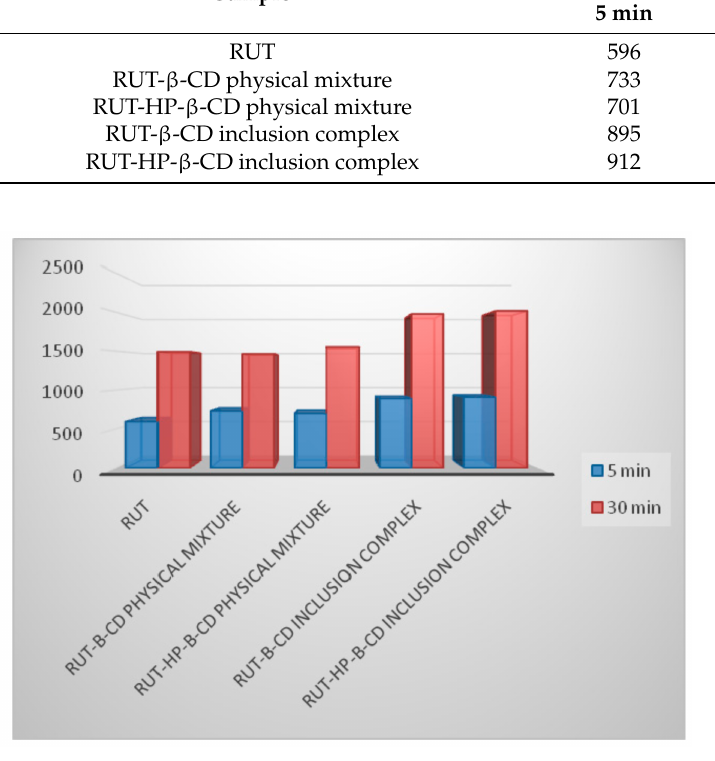
Figure 6. The evolution of FRAP